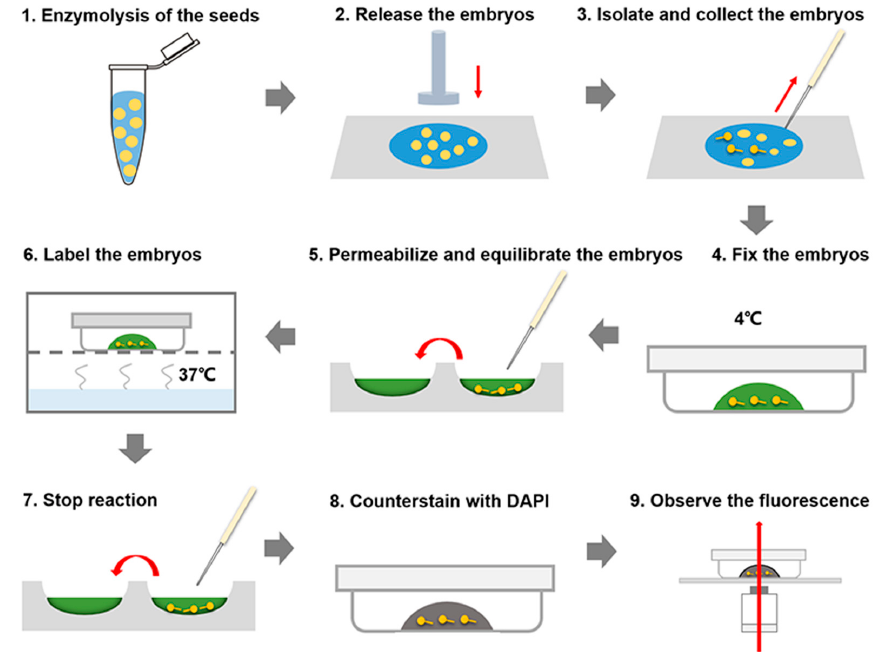
Figure 3. Schematic representation of the assay for the whole mount detection of the suspensor cell death by TUNEL. Steps 1–3 indicate the isolation of living embryos. Steps 4–9 indicate the detection of suspensor programmed cell death (PCD) by TUNEL.